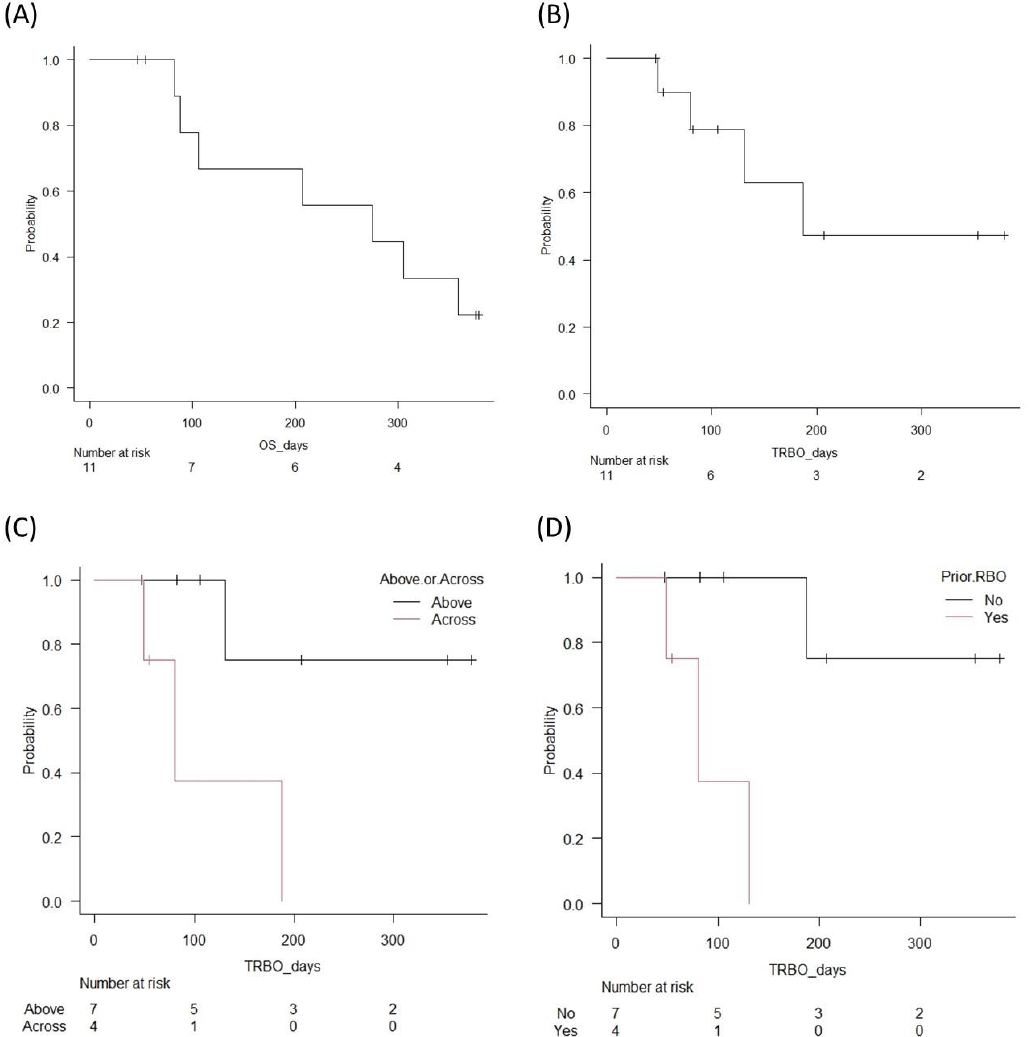
Figure 5. Kaplan–Meier curves for the stent patency and survival. ( A ) Overall survival (OS). Median OS was 275 days. ( B ) Time to recurrent obstruction (TRBO). Median TRBO was 187 days. ( C ) Com- parison of TRBO in above and across the papilla placements. Median TRBO was significantly longer (not applicable vs. 80 days, p = 0.031) in above-the-papilla placement than the across-the-papilla placement. ( D ) Comparison of TRBO in cases with or without prior RBO. Median TRBO was signifi- cantly longer (not applicable vs. 80 days, p = 0.005) in patients without prior RBO than in those with prior